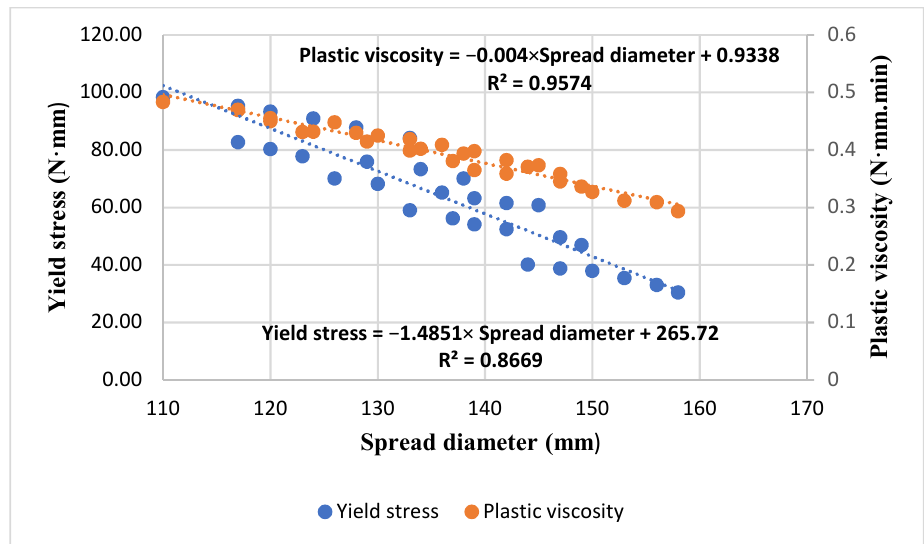
Figure 11. Correlation of the spread diameter with rheological parameters.